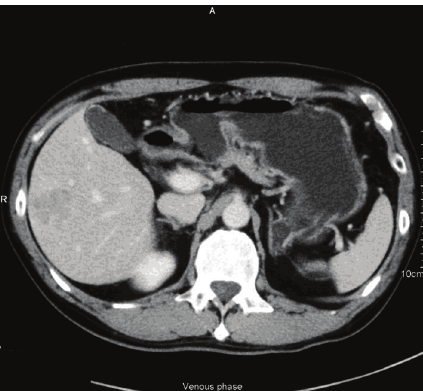
Figure 1: Preoperative CT scan showing the hepatocellular carci- noma at segment 6. The stomach was unremarkable. No gas was noted in the portal vein.